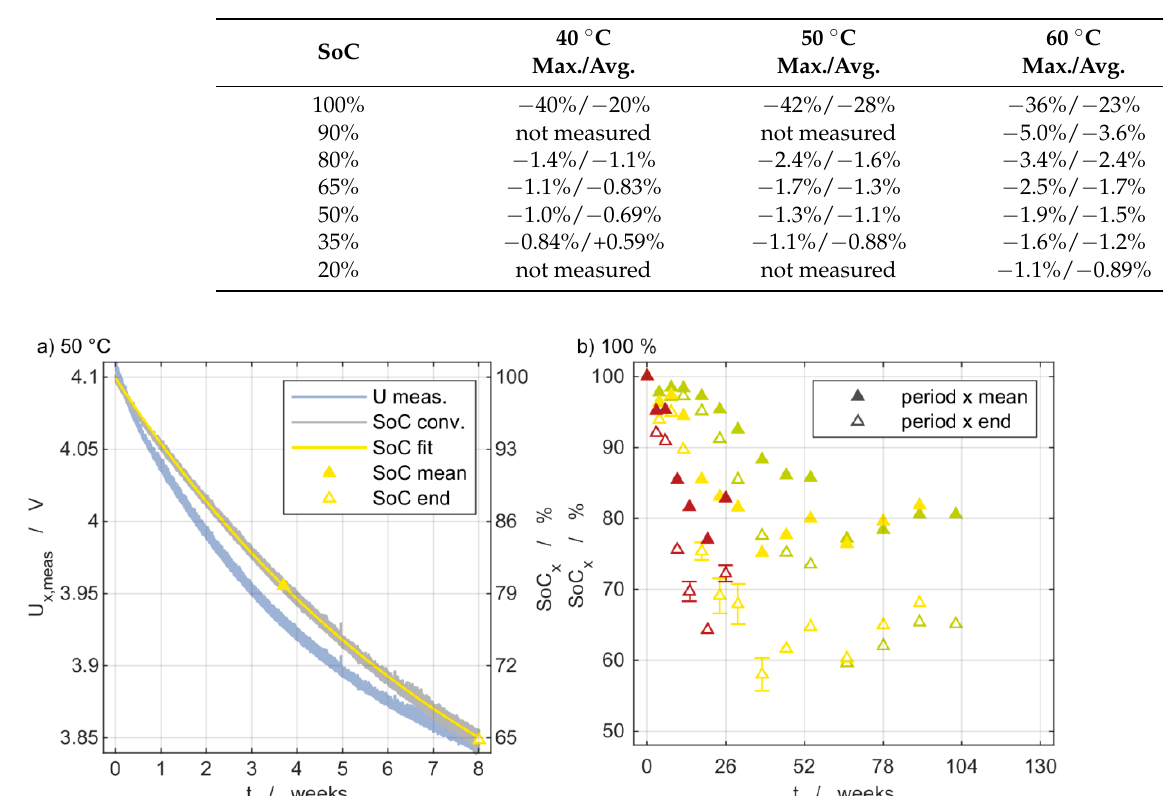
Table 2. Maximum and average self-discharge at the investigated storage conditions shown in Figure 1b. Compare Figure 2b for the self-discharge of 100% SoC at each storage period.